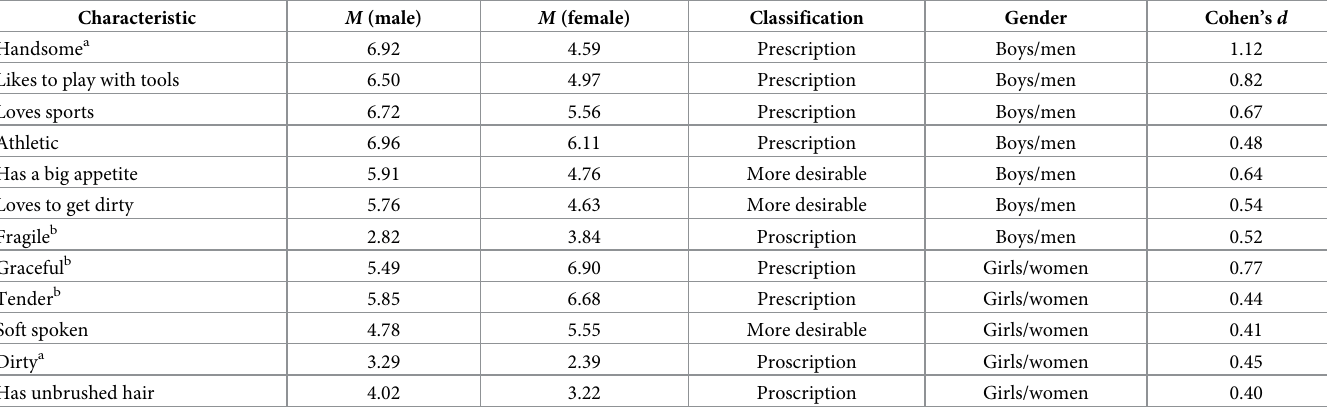
Table 5. Characteristics that were consistently rated as more desirable for one gender than the